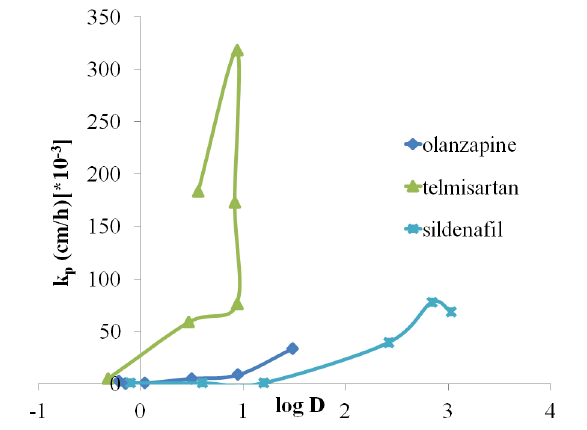
FIGURE 5 - % of unionized drug vs. Kp weakly acidic